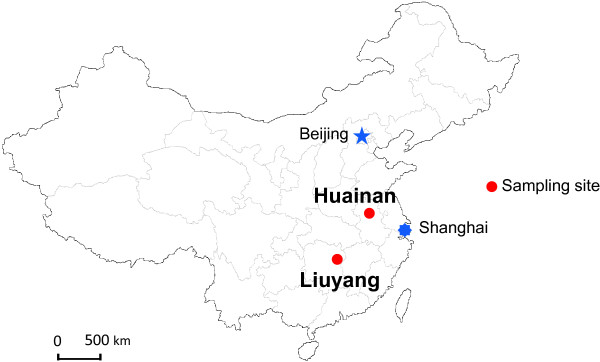
A map of China showing the distribution of mosquito sampling sites.